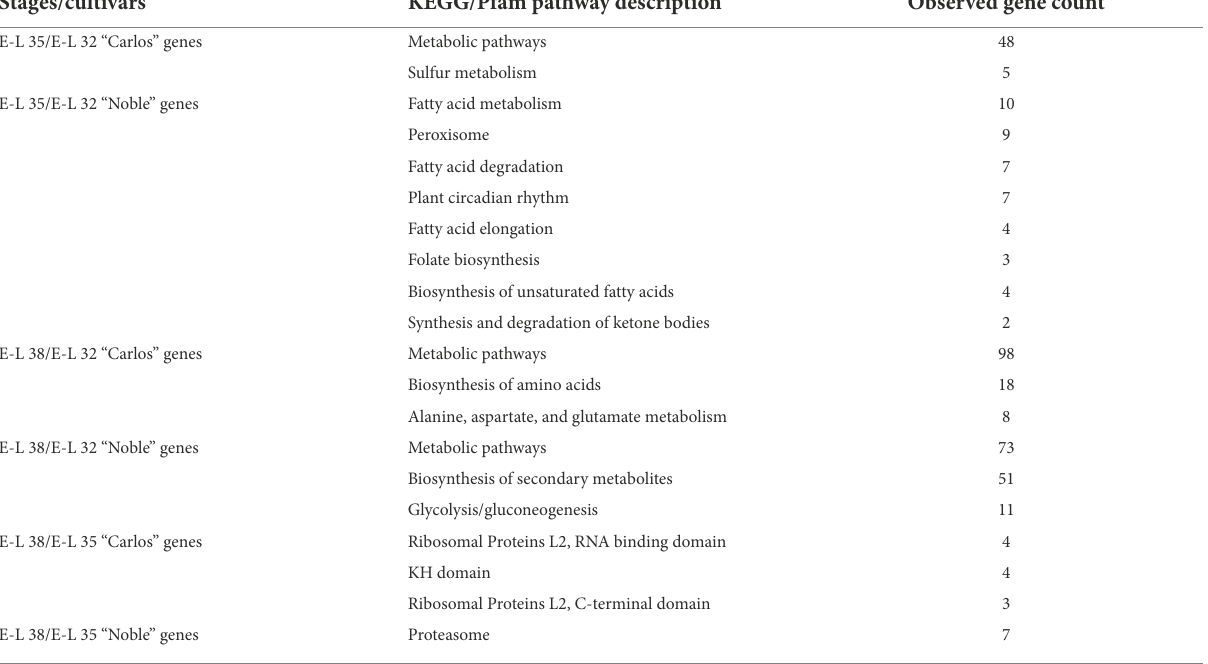
TABLE 2 KEGG pathway analysis of genes from immature to maturity development.